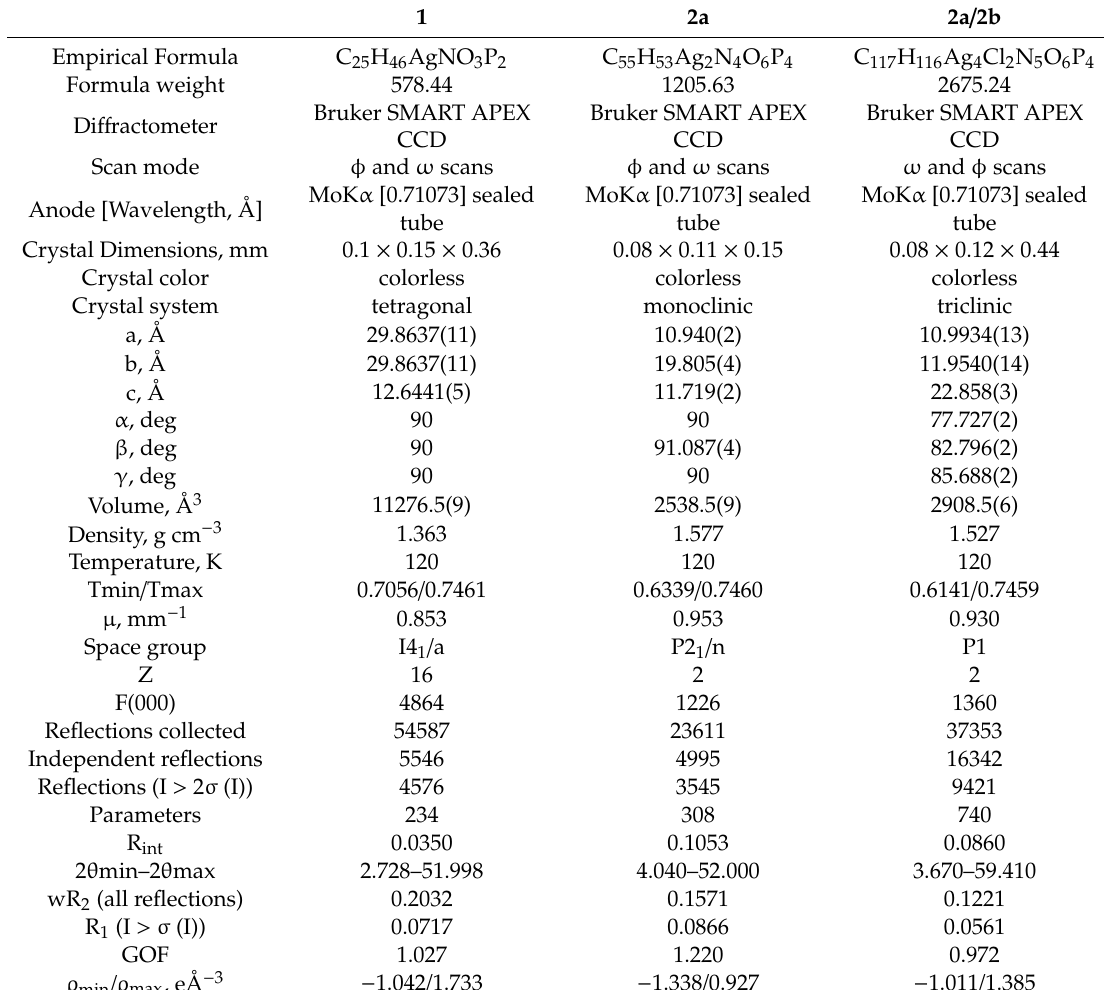
Table 1. Crystallographic data for complexes 1 , 2a , and 2a / 2b